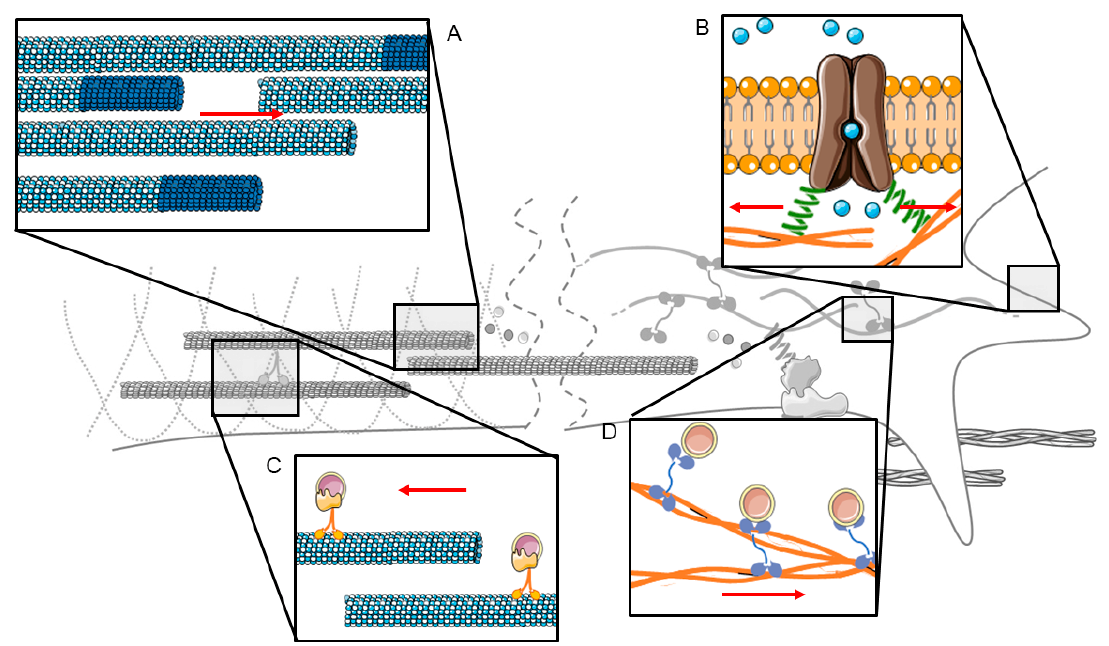
Figure 3. Mechanical force (red arrow) causes actin filament or MT remodeling at the GC or along the axon shaft ( A ), calcium influx by activation of MS channels ( B ), or modulation of vesicular transport along MTs ( C ) and actin filaments ( D ) .